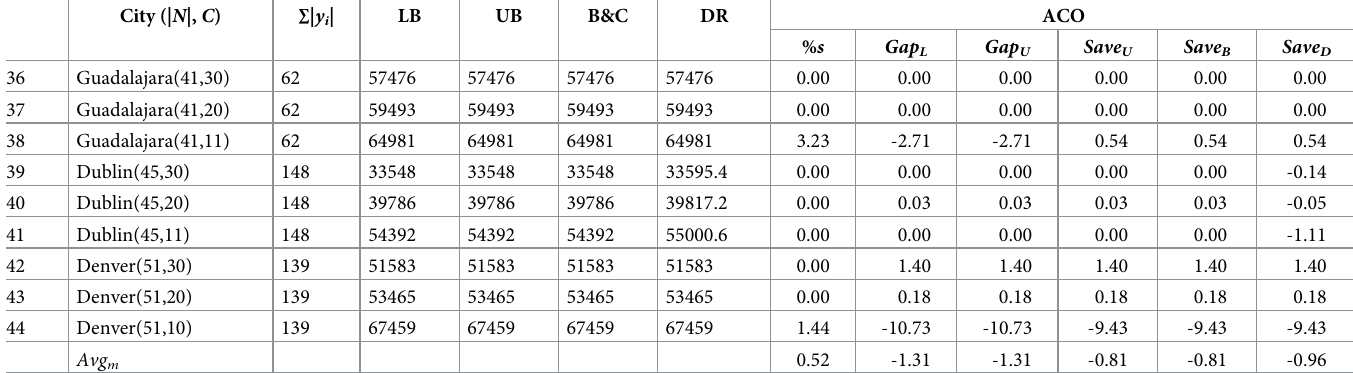
Table 2. Computational results for medium-size instances.